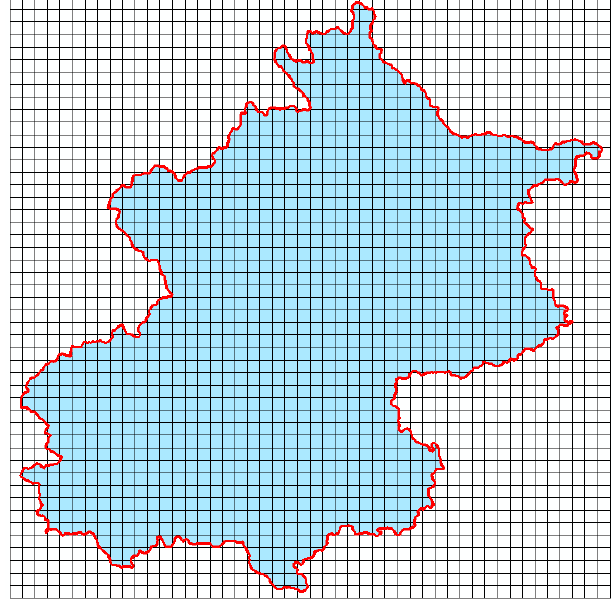
Figure 5. Training grids for the three population density prediction methods: autoregressive moving average (ARMA), long short-term memory (LSTM), and convolution LSTM (ConvLSTM).